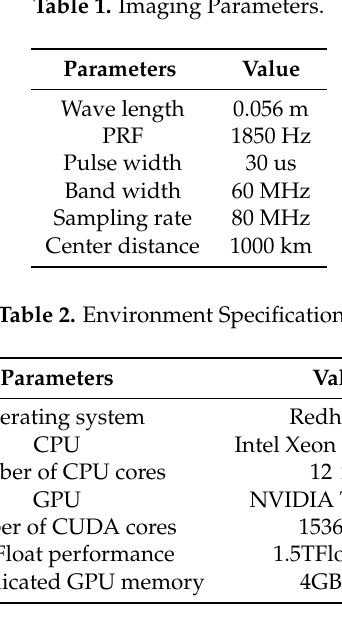
Table 1. Imaging Parameters.